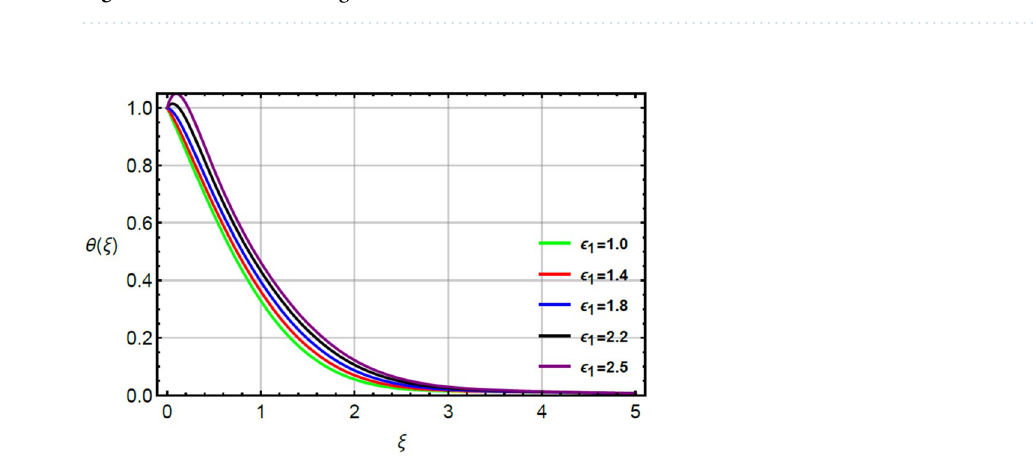
Figure 8. Character of α on g ′ .